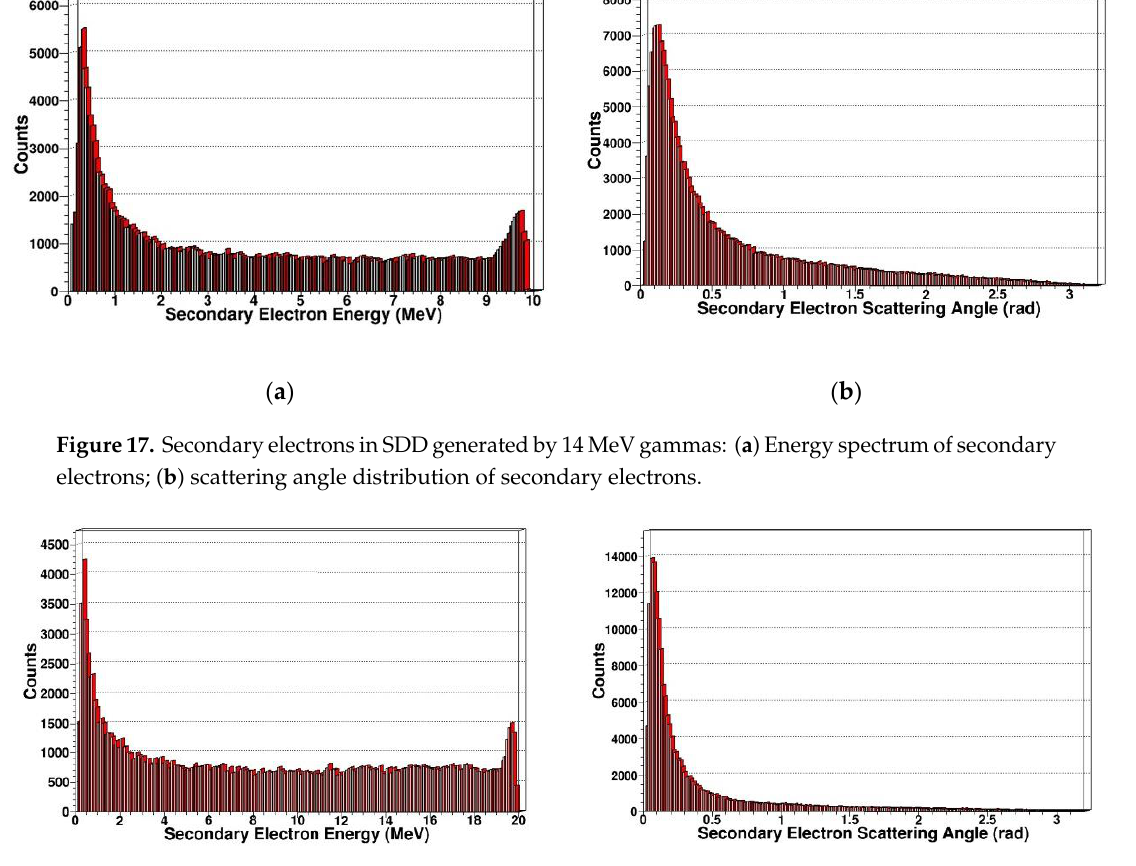
( b ) Figure 15. PKA spatial distribution in SDD generated by gammas: ( a ) PKA spatial distribution for 14 MeV gammas; ( b ) PKA spatial distribution for 20 MeV gammas. ( a ) ( b ) Figure 16. PKA energy spectrum in SDD generated by gammas: ( a ) PKA energy spectrum for 14 MeV gammas; ( b ) PKA energy spectrum for 20 MeV gammas. By three-dimensional coordinate reconstruction of PKA, we can see the number of PKA is very low. The number of recoil atoms generated by gamma photons which compare with neutrons is essentially negligible. This is because the probability of gamma photons producing PKAs in SDD is relatively small. However, gamma photons produce a large number of high-energy electrons in SDD. At the same time, the high-energy electrons can produce PKA in SDD. But the probability that high-energy electrons interact with lattice atoms in the SDD to produce PKA is very low, so the displacement damage generated by gamma photons is basically negligible.